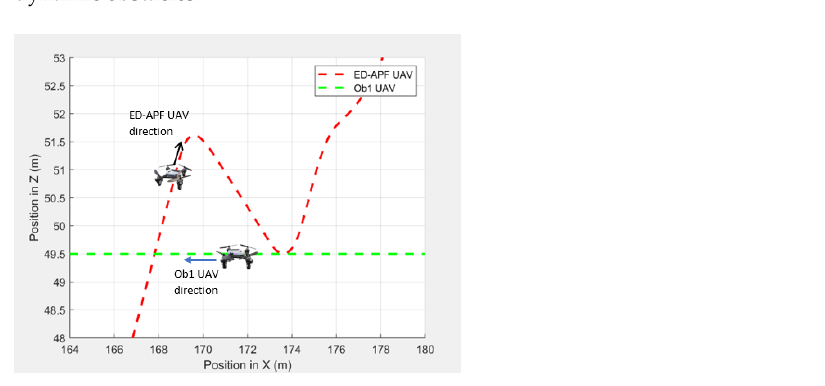
Figure 24. The UAV’s planned path for dynamic obstacle avoidance when encountering another UAV (Ob1).